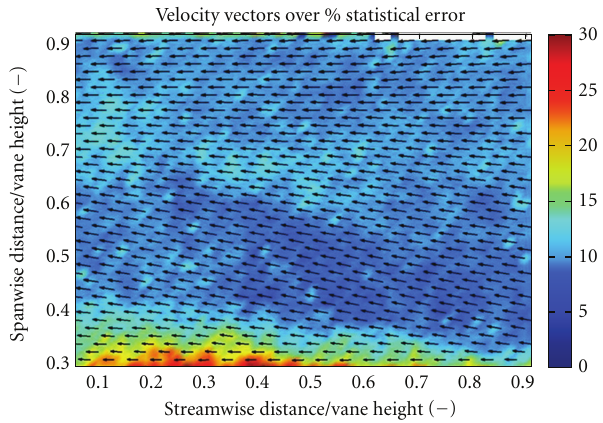
Figure 11: Velocity vectors superimposed on a color map of the % statistical error at 95% confidence.